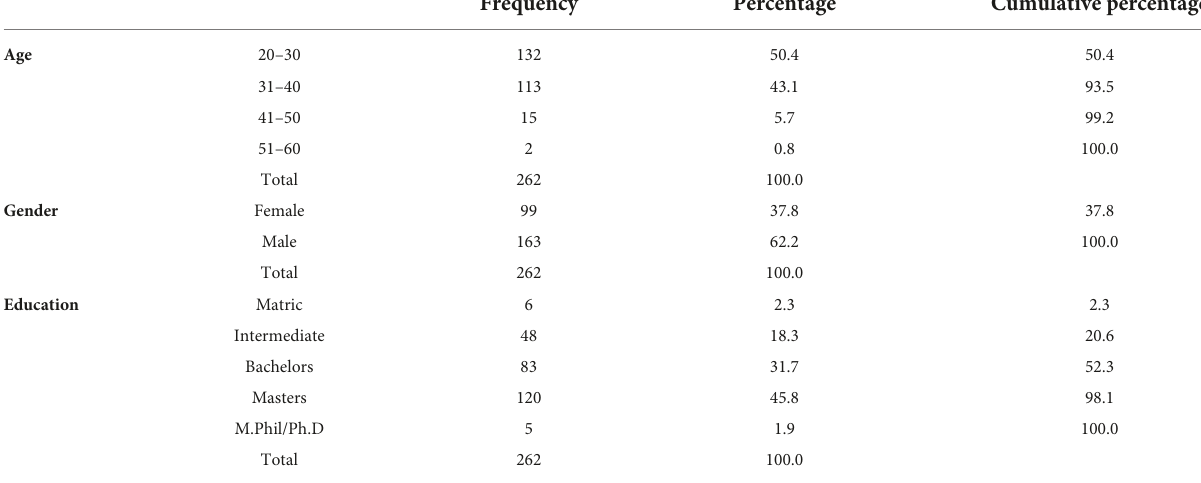
TABLE 1 Respondents’